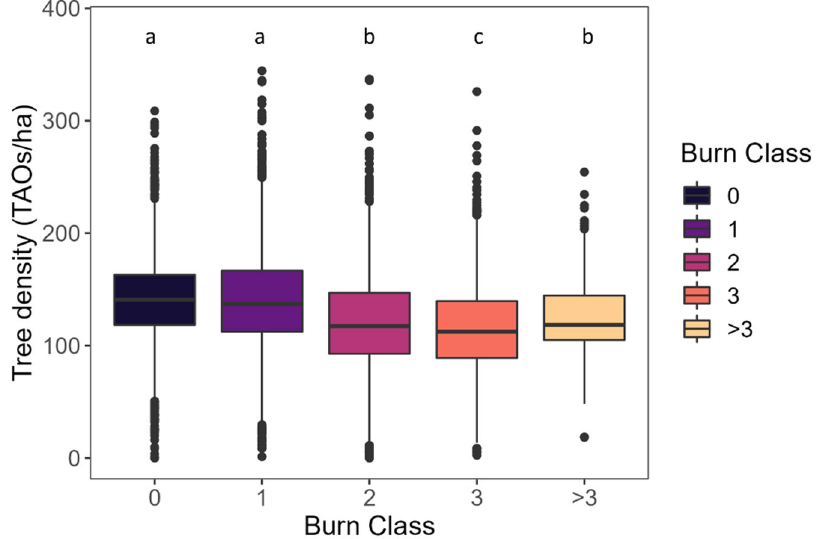
Figure 3. LiDAR-derived tree density (TAOs/ha) in samples differing in burn class. TAOs capture both live and dead tree stems. Letters are ordered alphabetically according to the magnitude of the mean value in each group (‘a’ corresponds to the group with the largest mean value) and different letters represent statistically significant differences in means according to one-way analysis of variance.